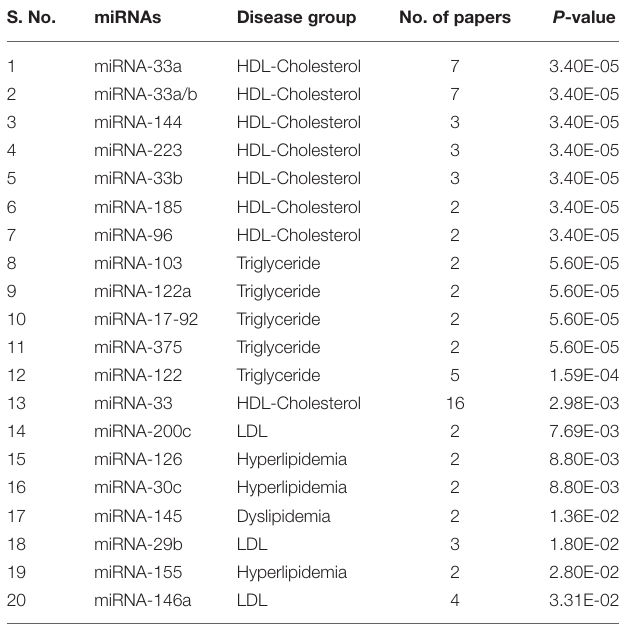
TABLE 2 | Top 20 significant associations between miRNA and disease P -value by one-sided Fisher’s exact method. S. No.